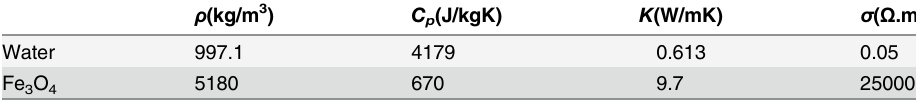
Table 2. Thermo-physical properties of water and magnetite-Fe 3 O 4